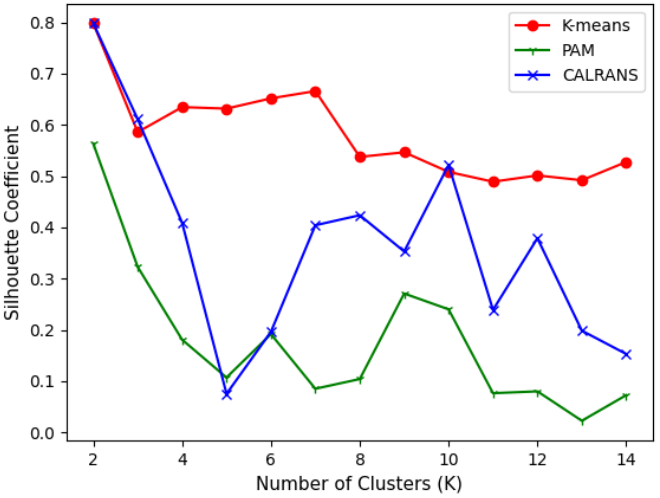
Figure 6. A comparison of the partitional clustering algorithm.